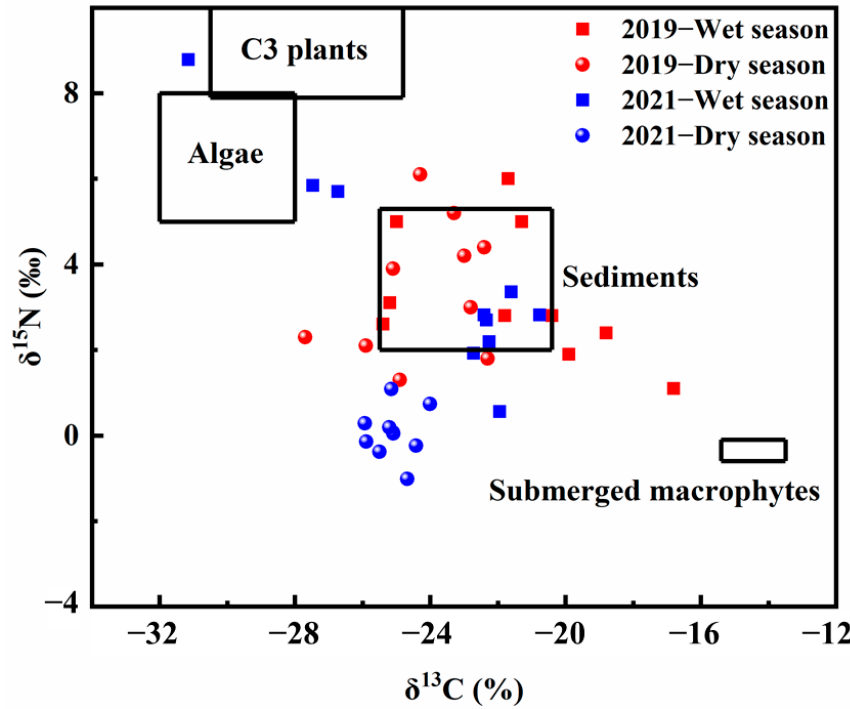
Figure 7. Mixing plots of the δ 15 N and δ 13 C values of the four different POM sources during the different periods (2019 − wet season, 2019 − dry season, 2021 − wet season, 2021 − dry season) of the Caohai Lake. The different POM sources were sediments, submerged macrophytes, algae, and C3 plants. Table 1. The δ 13 C and δ 15 N (‰) of different sources to POM in water of Caohai Lake.